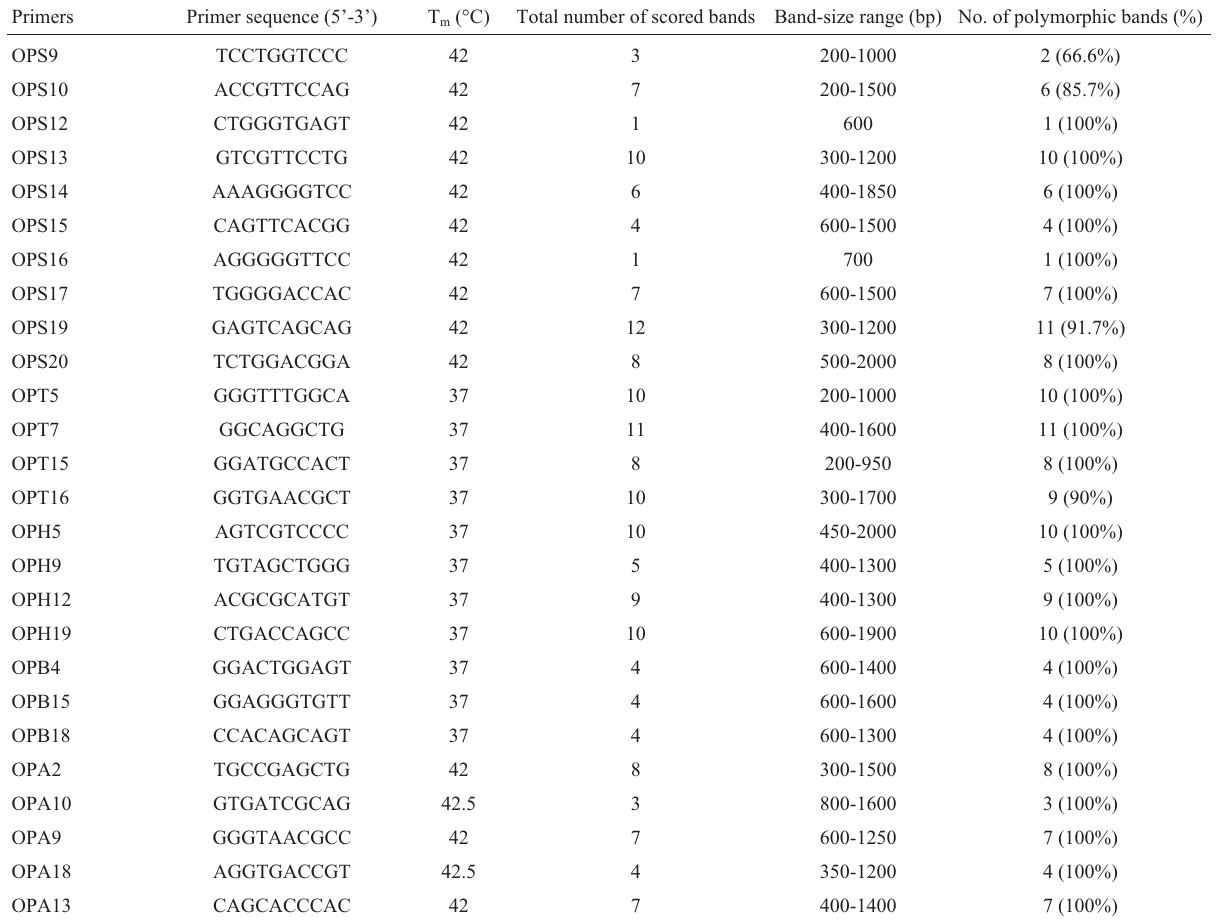
Table 2 - The list of primers used, their sequences, T m , number of bands generated, size-range and degree of polymorphism. Primers Primer sequence (5’-3’) T m (°C) Total number of scored bands Band-size range (bp) No. of polymorphic bands